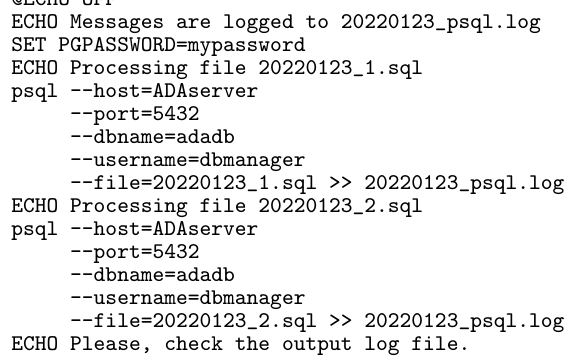
Figure 5. An example of a shell file running psql, reducing to a minimum the operational